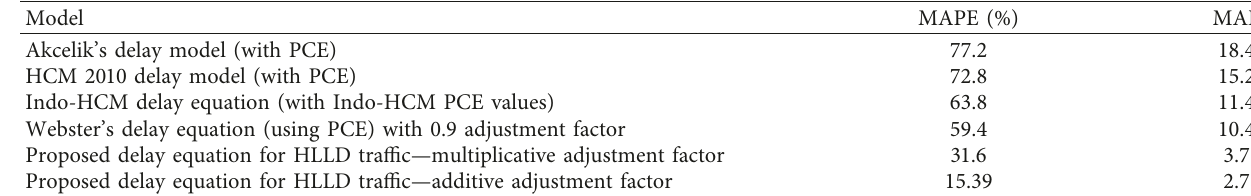
Table 8: Summary of accuracy measures of delay